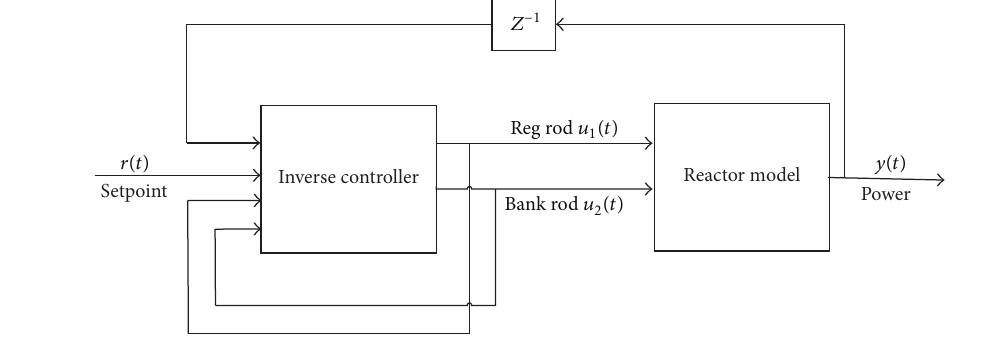
Figure 4: Block diagram of DIC on RSG-GAS.